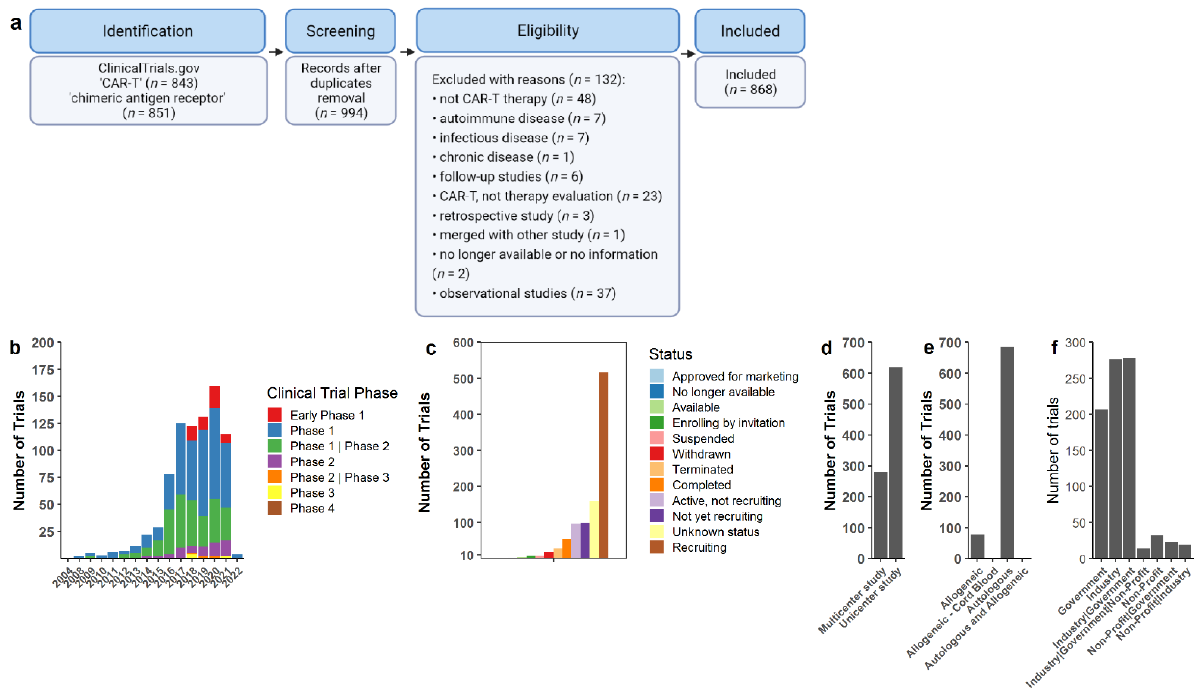
Figure 1. CAR-T cells on clinical trials. ( a ) Flow chart of the systematic review methodology showing the keywords, duplicate removal, and eligibility criteria applied as filters. ( b ) Number of trials by design type along the years. ( c ) Overall status of clinical trials applying CAR-T cells. ( d ) Multicenter or unicenter studies as described by each trial or observed by locations. ( e ) CAR-T cell source used in trials. The majority of trials described autologous, allogeneic cord blood ( n = 1), and allogeneic or autologous T cells ( n = 2). ( f ) Funding support described for clinical trials.